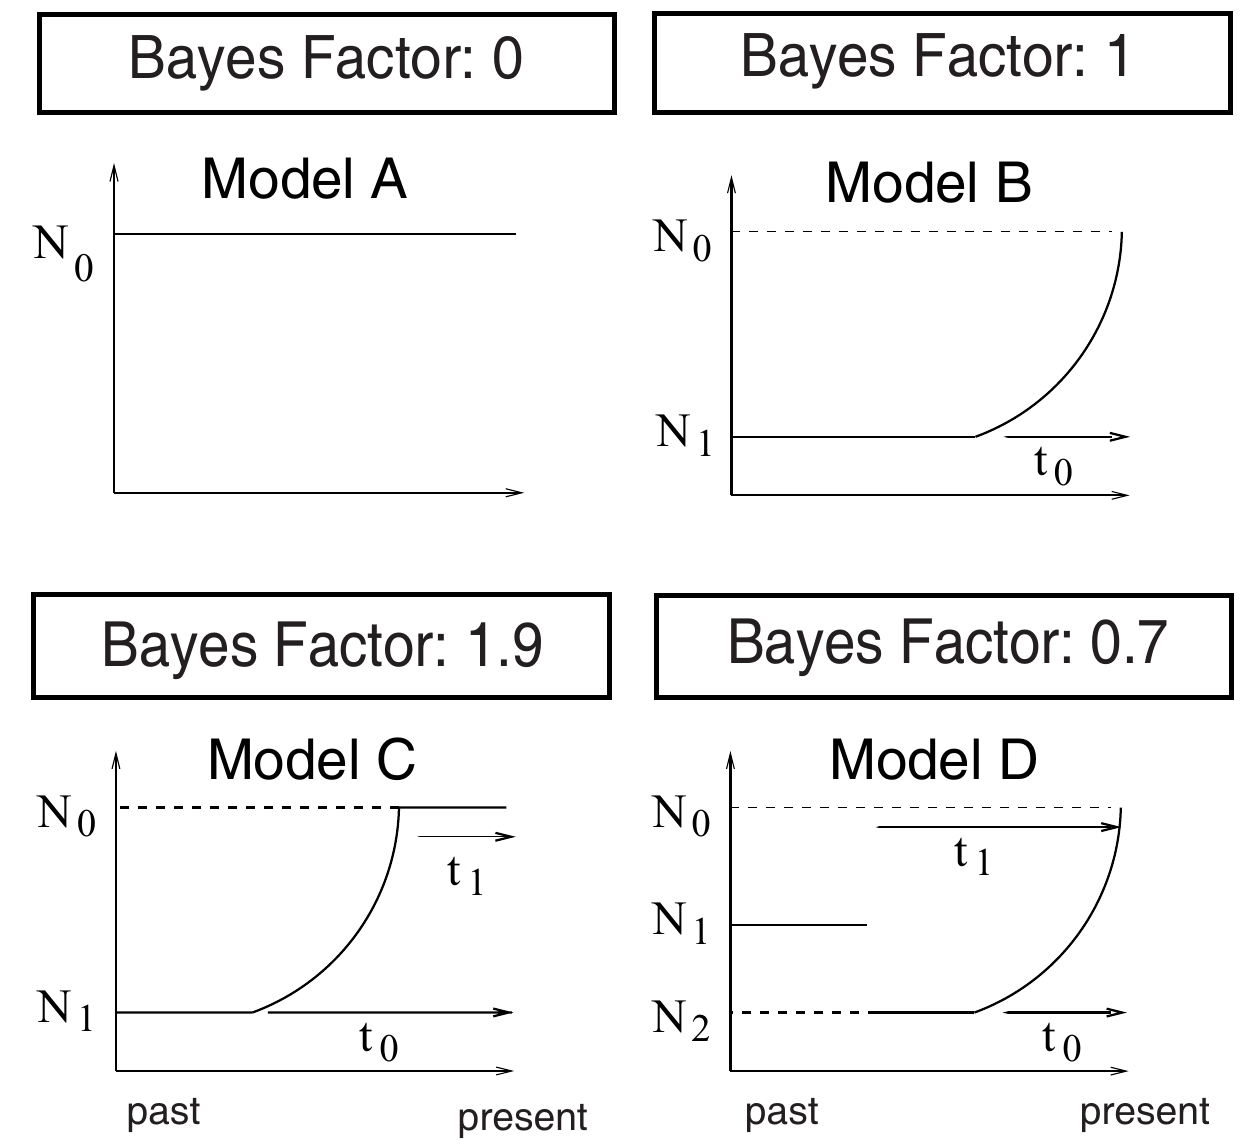
Figure 3. Bayes factors. The 4 demographic scenarios (Models A–D) and their associated Bayes factors. Model A is the model with constant population size, N 0 . Model B is a model with an exponentially growing population size (present size, N 0 , ancestral size, N 1 , time since the onset of expansion, t 0 ). In Model C, the growth is exponential between two periods with constant size (present size, N 0 , ancestral size, N 1 , time since the onset of expansion, t 0 , time since the end of expansion, t 1 ). Model D is similar to Model B, but it includes an ancient bottleneck before expansion. Variants of these 4 models, including variable mutation rates across loci, are considered here. The Bayes factors (top boxes) correspond to the ratio of the weight of evidence of each model to the weight of evidence of Model B. Two window sizes, d 0.01 and d 0.05 , were used when computing the Bayes factors. These window sizes correspond to the 1% and 5% quantiles of the distance between the values of the summary statistics obtained under Model B and the observed values of the summary statistics. The Bayes factors were identical for the 2 window sizes and for values rounded for one decimal place, except for Model C, for which a minor difference was observed (1.8 for d 0.05 instead of